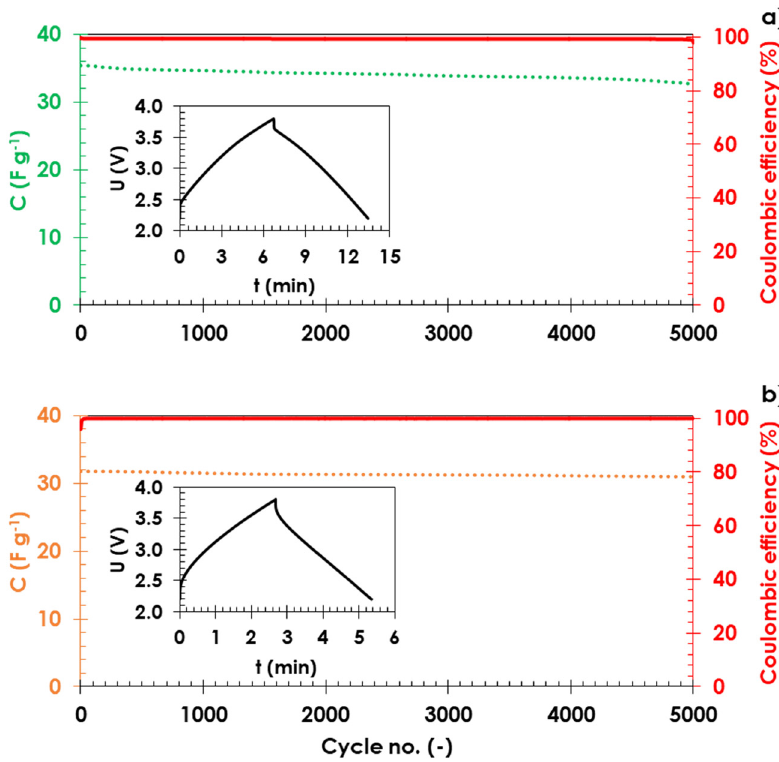
Figure 5: Speci fi c capacitance of NIC with ( a ) hard carbon or ( b ) tin phosphide - negative electrode versus cycle number. Cells were galvanostatically charged/discharged in the voltage range of 2.2 – 3.8 V for 5,000 cycles at the current density ( a ) 125 mA g − 1 or ( b ) 250 mA g − 1